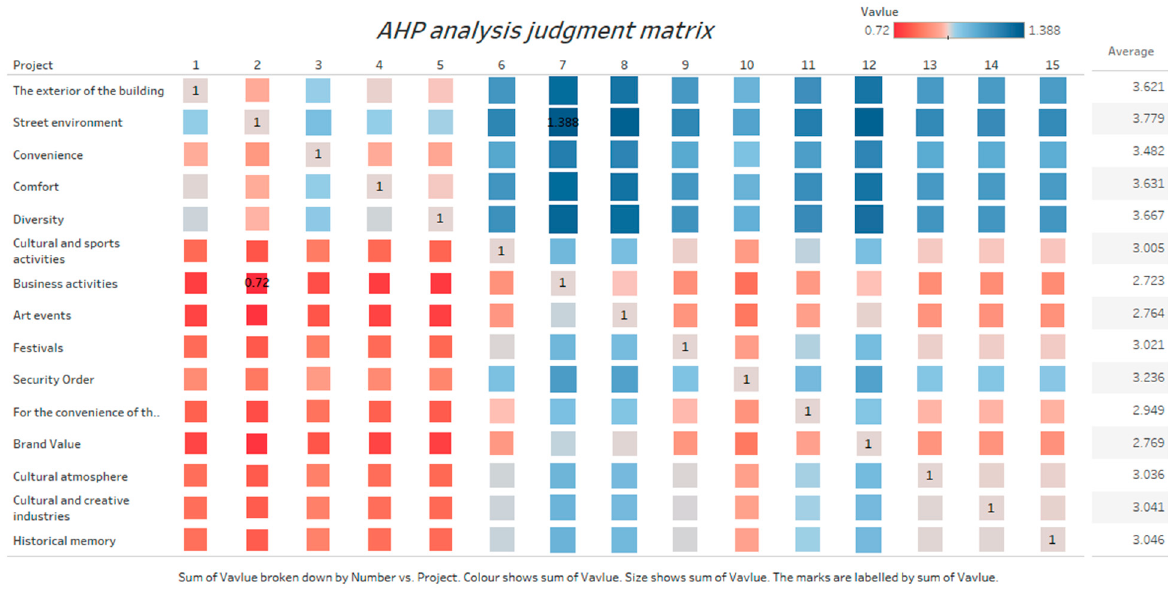
Figure 8. AHP matrix diagram.